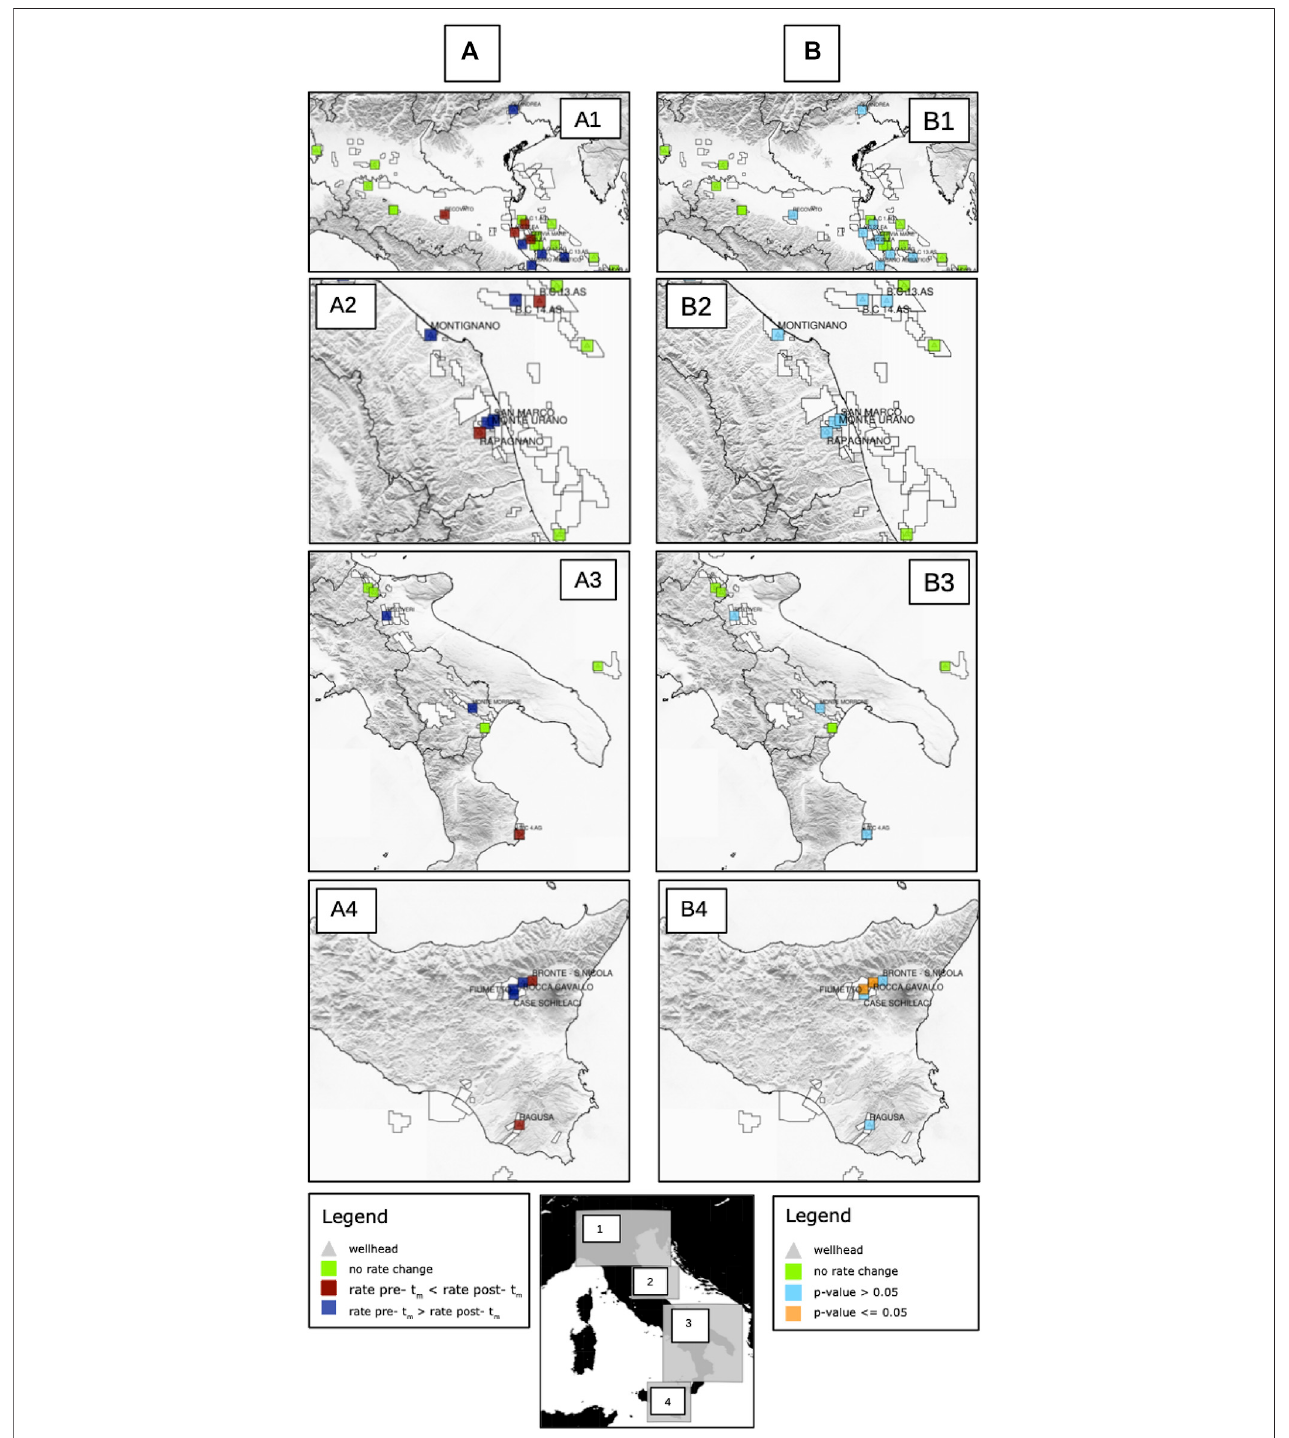
FIGURE 8 | Map of the pre – and post – t m seismicity rate changes (A) and p values (B) for the 43 gas-producing leases analyzed in this work considering the seismicity located with-in δ x (cid:1) 5 km from producing wells.